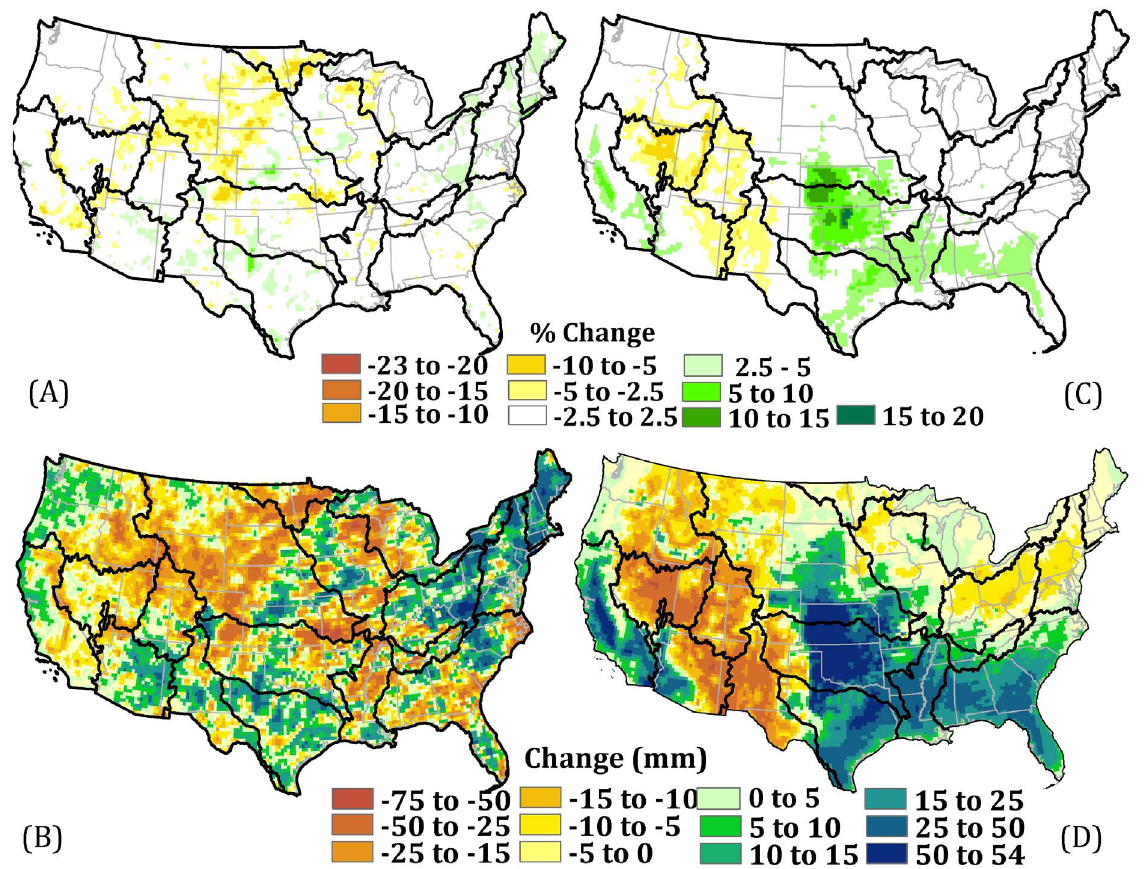
Figure 3. Change in mean annual precipitation and potential evapotranspiration for 1981–2004 expressed in A) percentage change in mean annual precipitation; B) change in mean annual precipitation (millimeters); C) percentage change in mean annual PET; and D) change in PET (millimeters) under the biofuel scenario. Percent change under the biofuel scenario relative to the baseline scenario for a Baseline xi { Biofuel xi | 100 where x is either P or PET and i is year between 1981 and 2004. given location is estimated as the mean of: Baseline xi